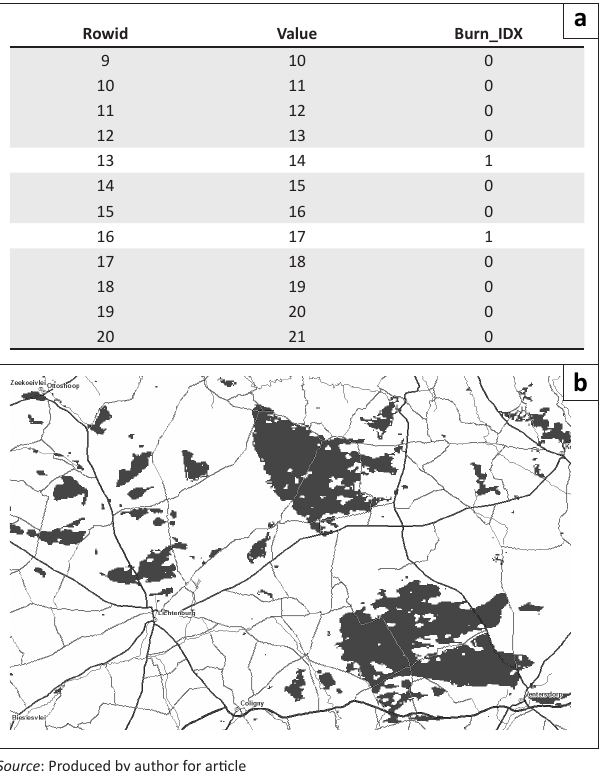
FIGURE 6: New dataset and map created from data values representing burn scars.